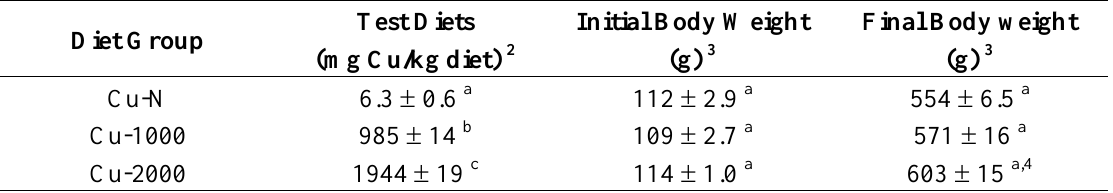
Table 1. Cu content in test diets and body weight of rats 1 .